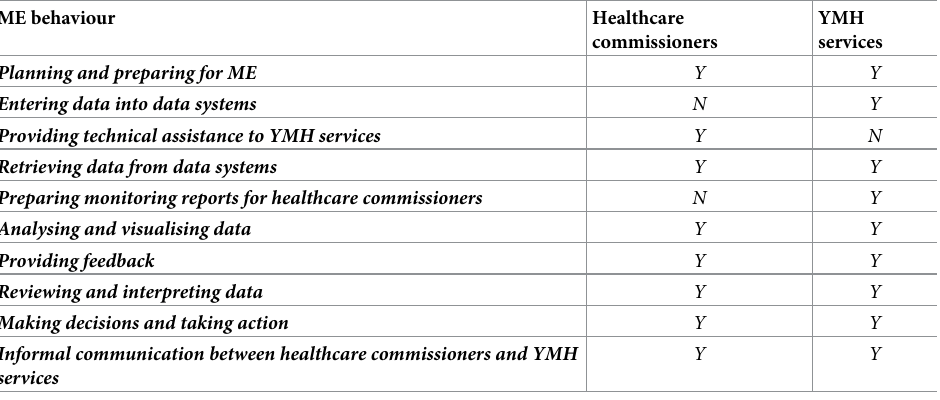
Table 2. ME behaviours performed by healthcare commissioners and YMH